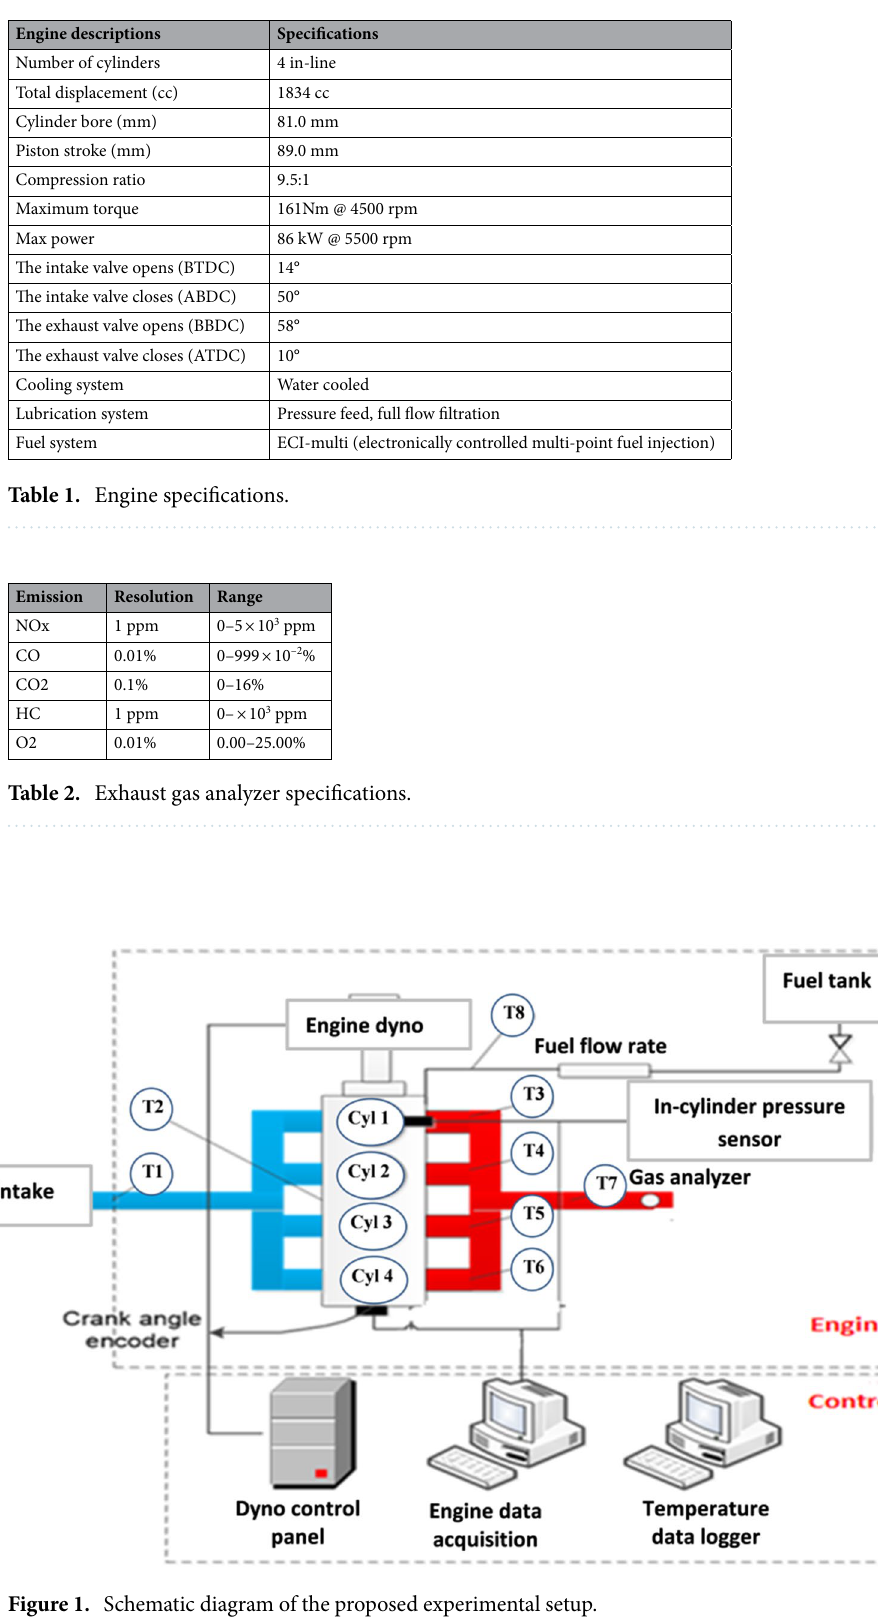
Figure 1. Schematic diagram of the proposed experimental